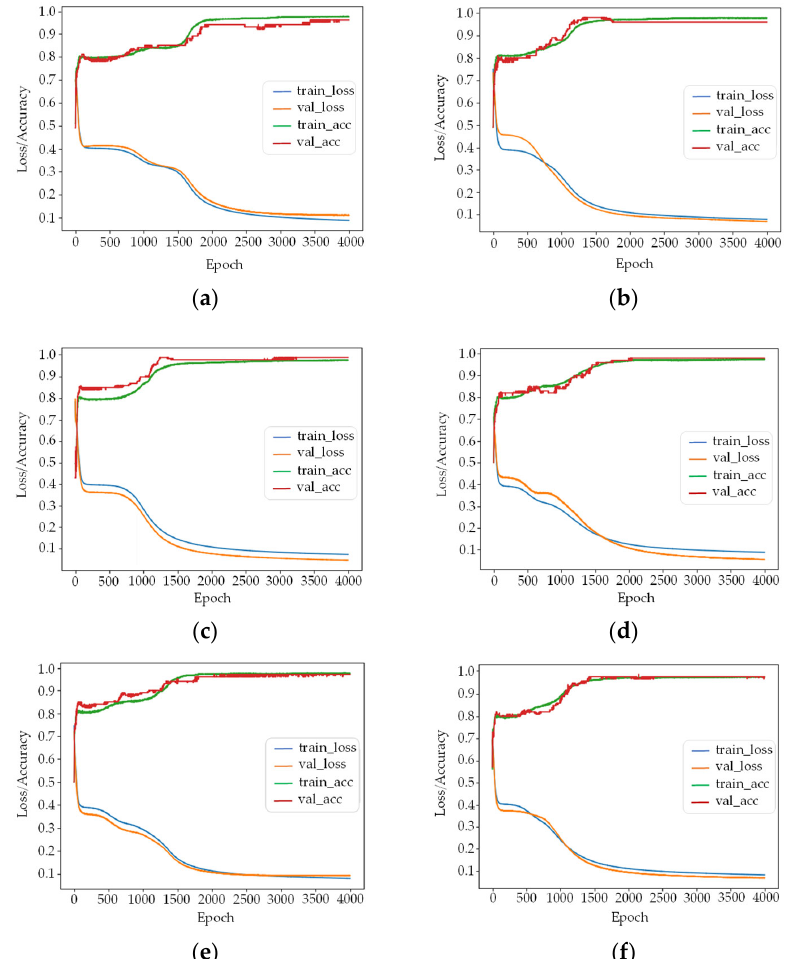
Figure 5. Training loss and accuracy of selecting different node numbers in the hidden layer of the BP neural network model. Figures ( a – f ) represent the training results of the model when the number of hidden nodes is 3–8, respectively.